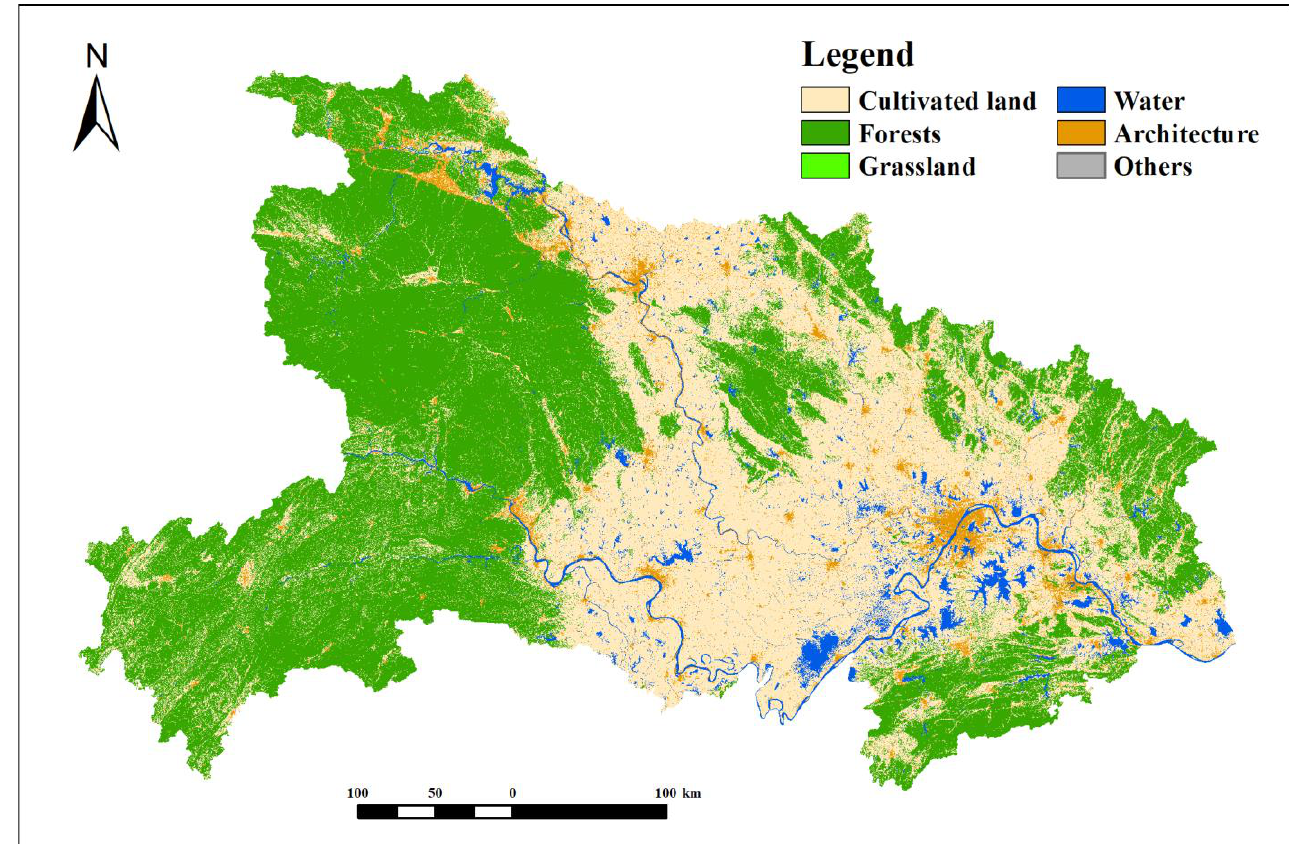
Figure 8. Simulation results for land use in 2035 in the natural development scenario.